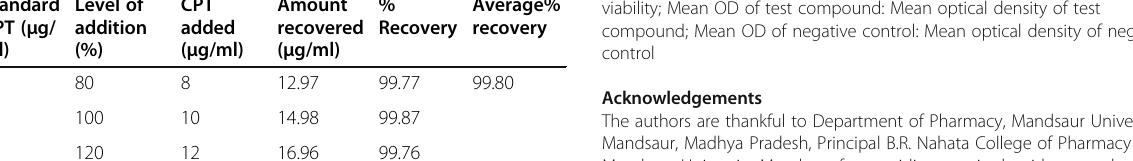
Table 3 Accuracy measurement by % recovery method Standard CPT ( μ